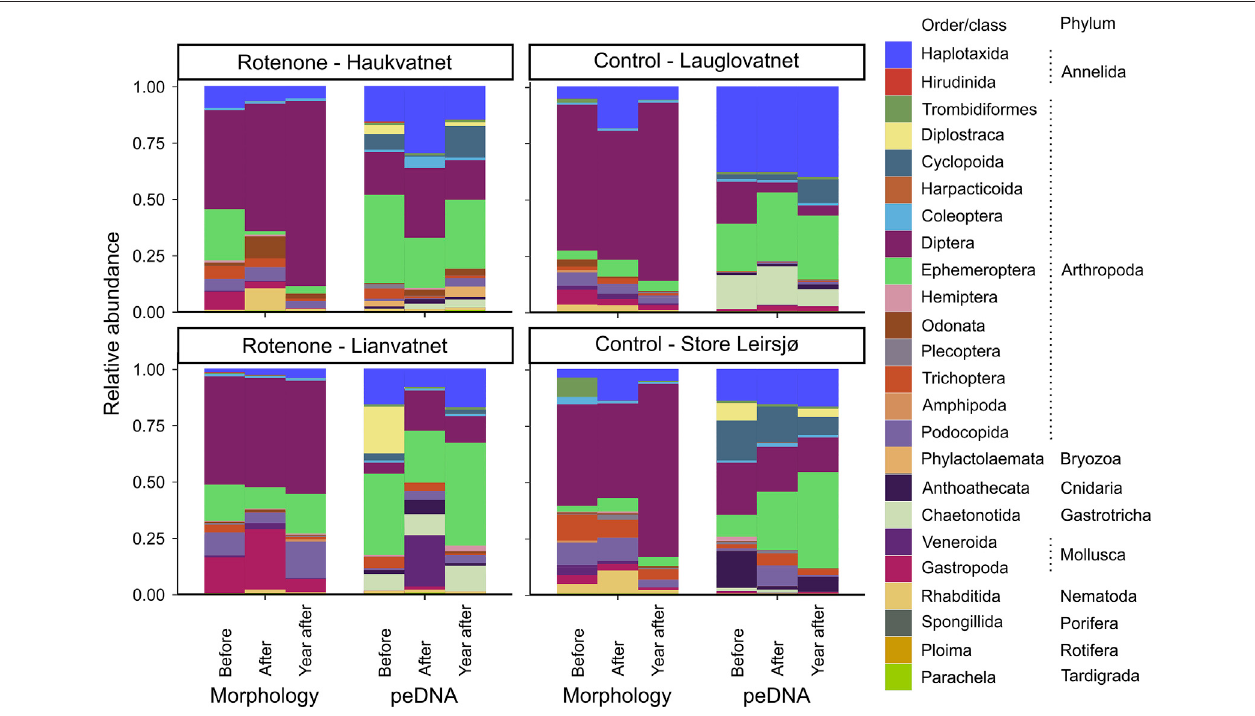
FIGURE 6 | Relative abundances of invertebrates grouped by orders/classes and phylum just before, just after and 1 year after the rotenone treatment for identi fi cation based on morphology and on metabarcoding of peDNA. Treated lakes are in the left panels and control lakes in the right panels.